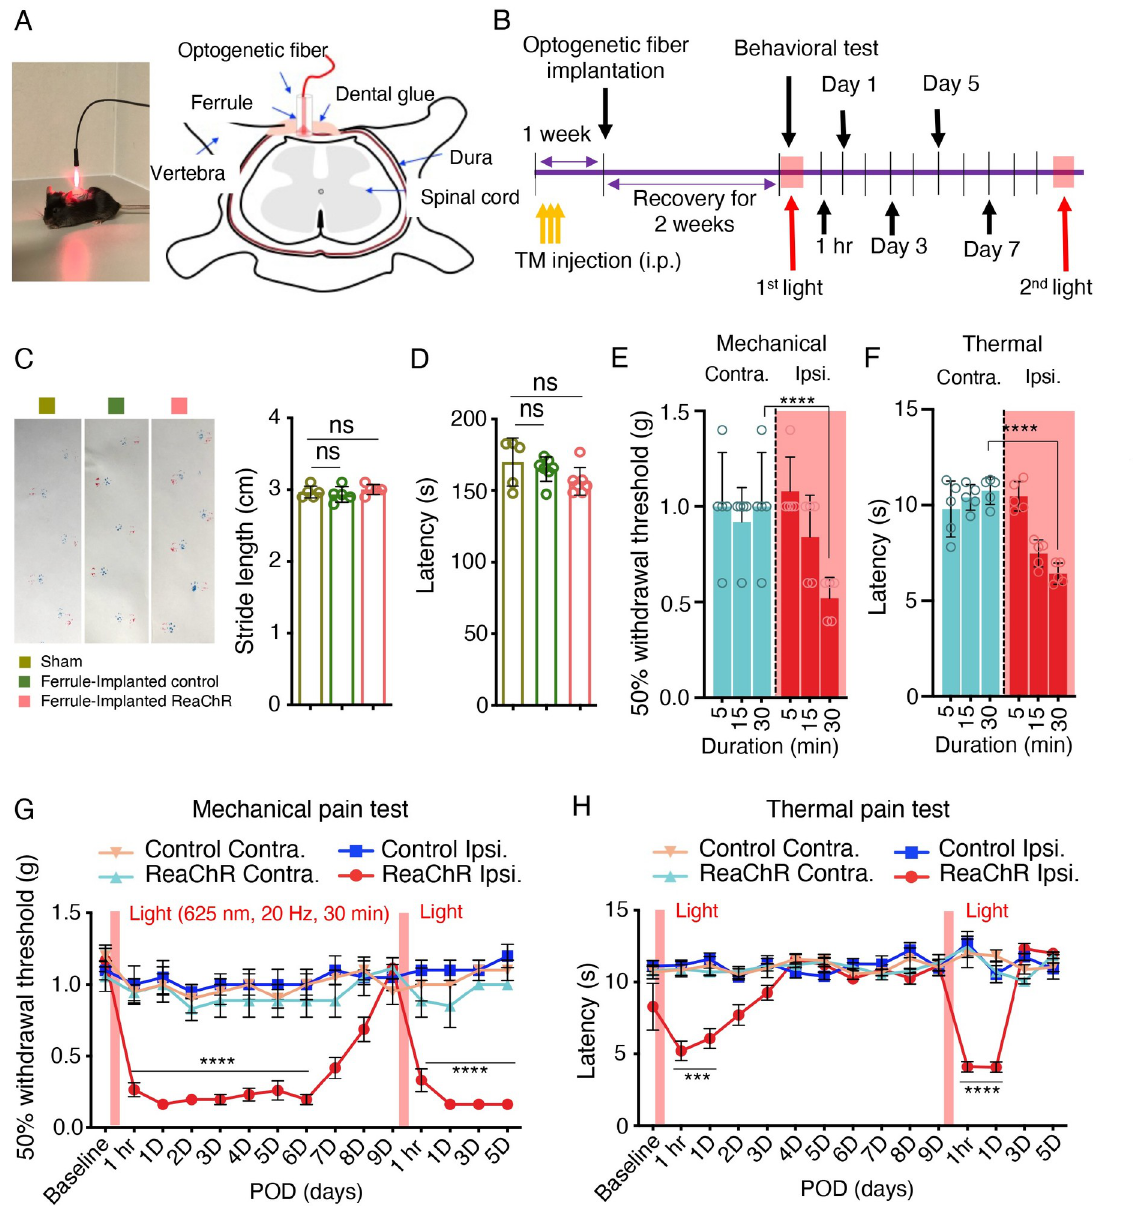
Fig 3. Optogenetic stimulation of microglia induces mechanical allodynia and thermal hyperalgesia. (A) Image displaying LED stimulation (red light: 625 nm, 45 ms light on, 5 ms light off, 20 Hz) in a mouse (left) and a schematic representation of the optogenetic ferrule placement region for light stimulation of mouse spinal cord (right). (B) Timeline of experimental procedures. (C) Gait analysis using the footprint test displays the stride length of mice after sham surgery, control mice after implantation of the optic ferrule (ferrule-implanted control), and ReaChR mice after implantation of the optic ferrule with ReaChR activation with 30-min duration (ferrule-implanted ReaChR). n = 5 mice/group. (D) Rotarod test of motor coordination in the 3 groups described in C. n = 5 mice/group. One-way ANOVA. (E, F) Mechanical allodynia (E) and thermal (F) pain hypersensitivity of ReaChR mice at 1 h after light stimulation with different durations (5, 15, and 30 min). Both contralateral (Contra.) and ipsilateral (Ipsi.) side of light stimulation were measured. n = 5 mice/group. ���� P < 0.0001. Two-way ANOVA with multi-comparisons. (G, H) Mechanical (G) and thermal (H) pain hypersensitivity of ReaChR mice after the first and second light stimulation for 30 min. Red bar indicates the time points of light stimulation at day 0 and day 9. Data are presented as mean ± SEM. n = 7–8 mice/group. ��� P < 0.001, ���� P < 0.0001 Control Ipsi. vs. ReaChR Ipsi. Two-way ANOVA with multi-comparisons. For data plotted in graphs, see S1 Data. ReaChR, red-activated channelrhodopsin; TM, tamoxifen.